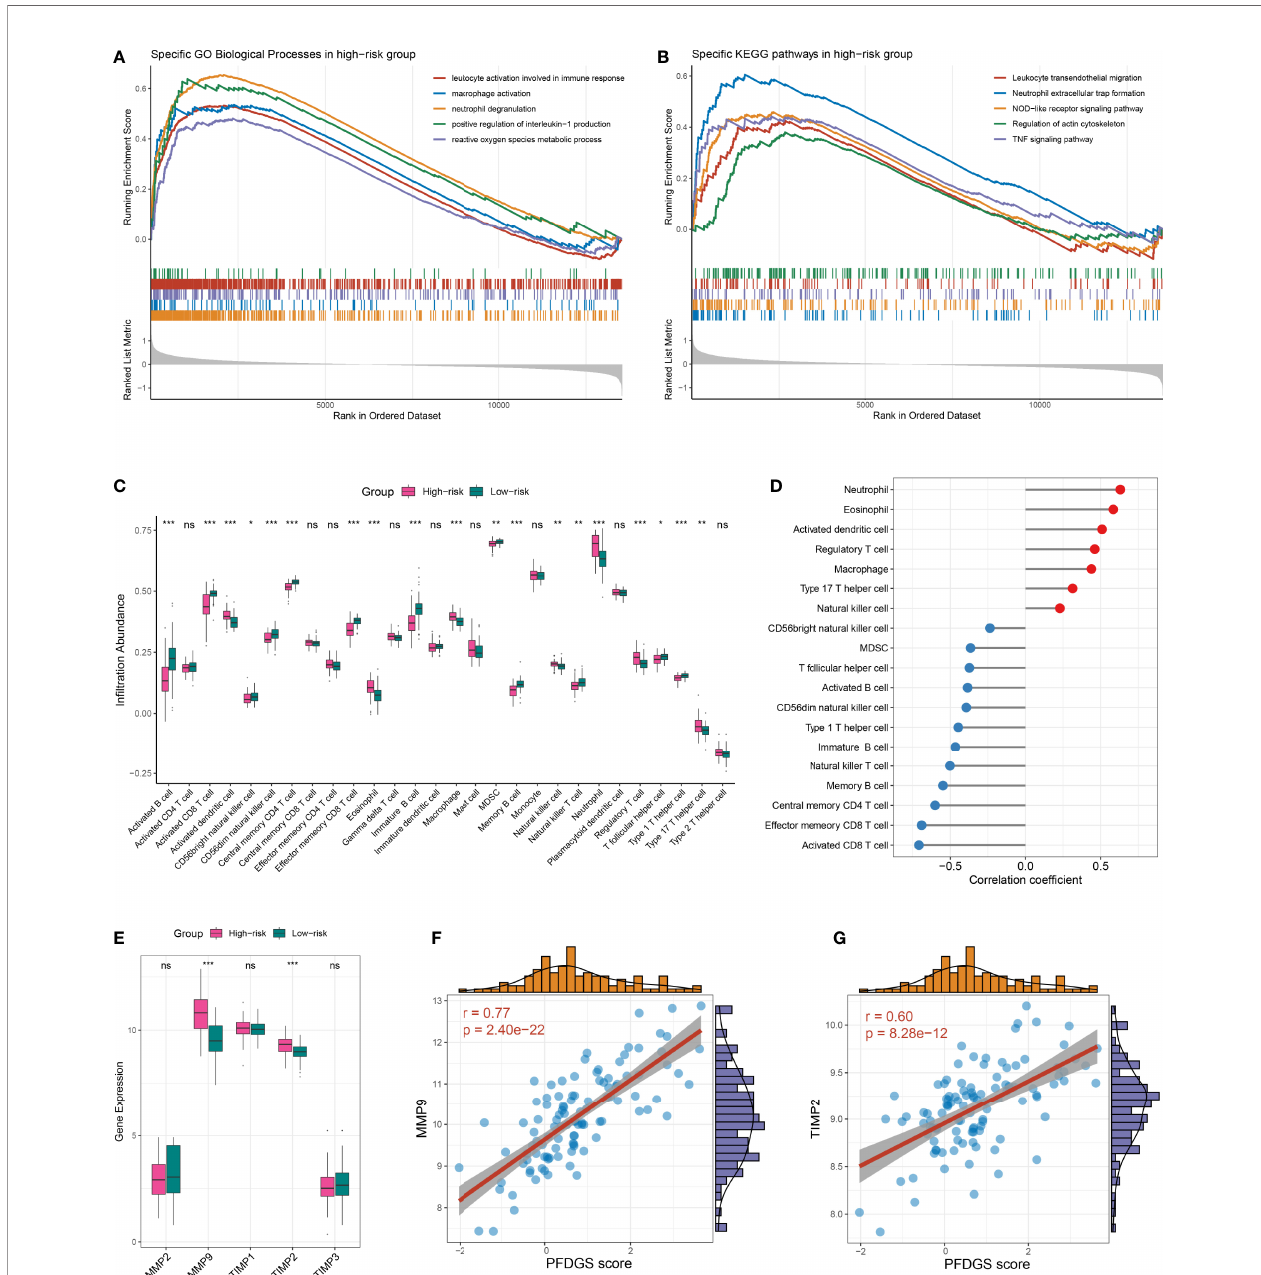
FIGURE 8 | Biological signi fi cance underlying the PFDGS. (A, B). GO (A) and KEGG (B) gene set enrichment analysis were performed between high- and low-risk groups. (C) Comparison of immune cell relative abundance between high- and low-risk groups. (D) Relationship between PFDGS and immune cell abundance. (E) Comparison of MMP2, MMP9, TIMP1, TIMP2, and TIMP3 expression between high- and low-risk groups. (F, G). Correlation of PFDGS with MMP9 (F) and TIMP2 (G) expression. For all boxplots, ns, P > 0.05; * P < 0.05, ** P < 0.01, *** P <